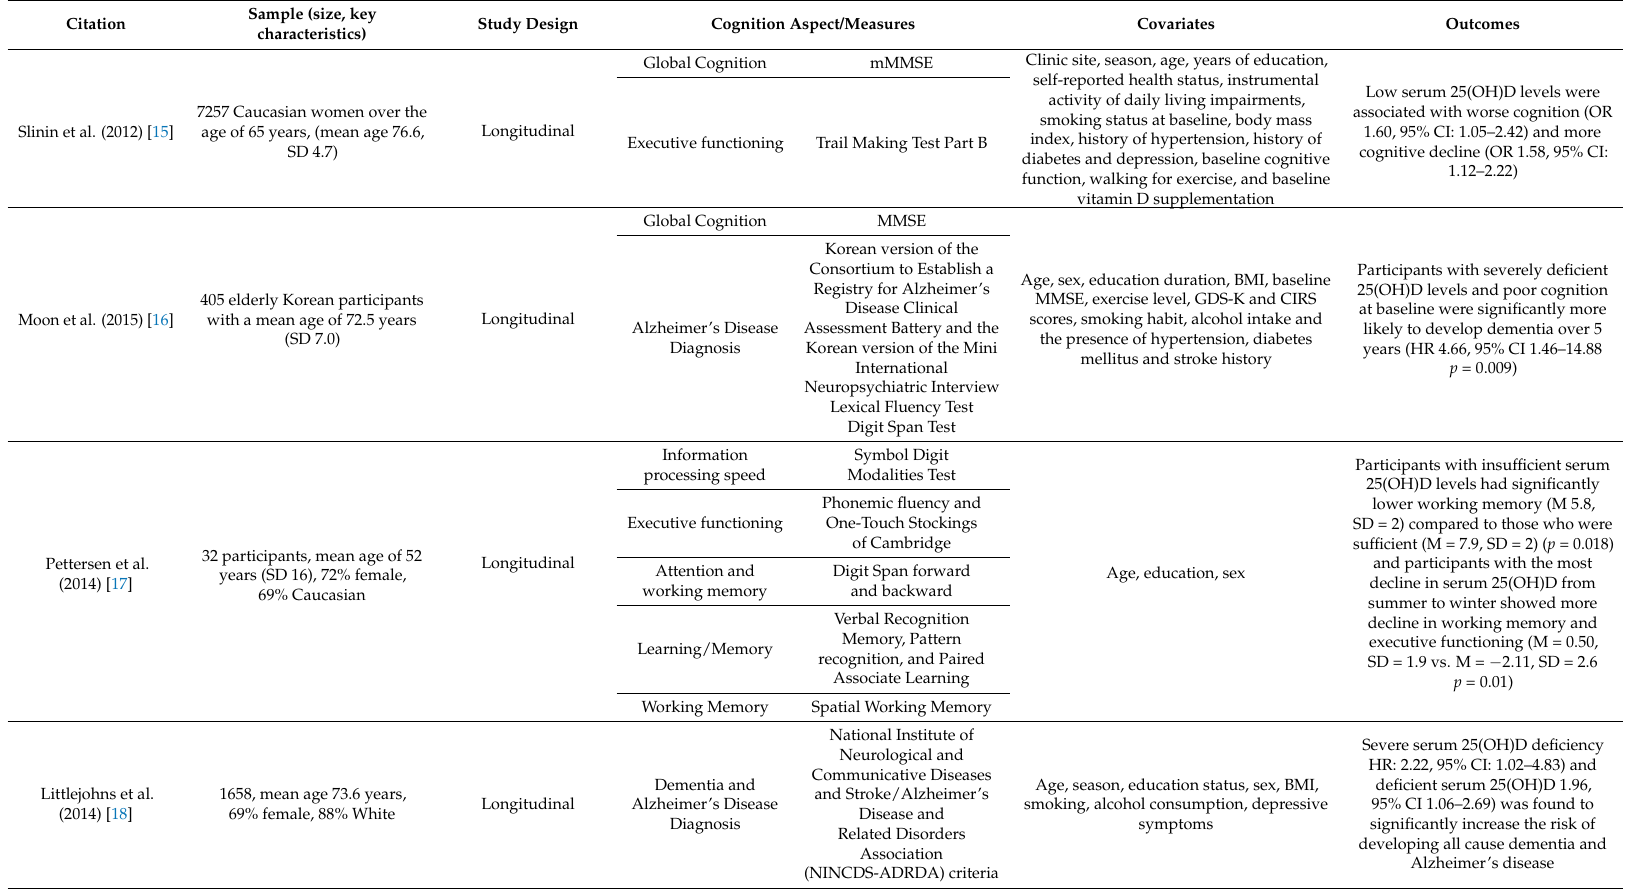
Table 2. Longitudinal studies examining serum 25(OH)D and cognitive